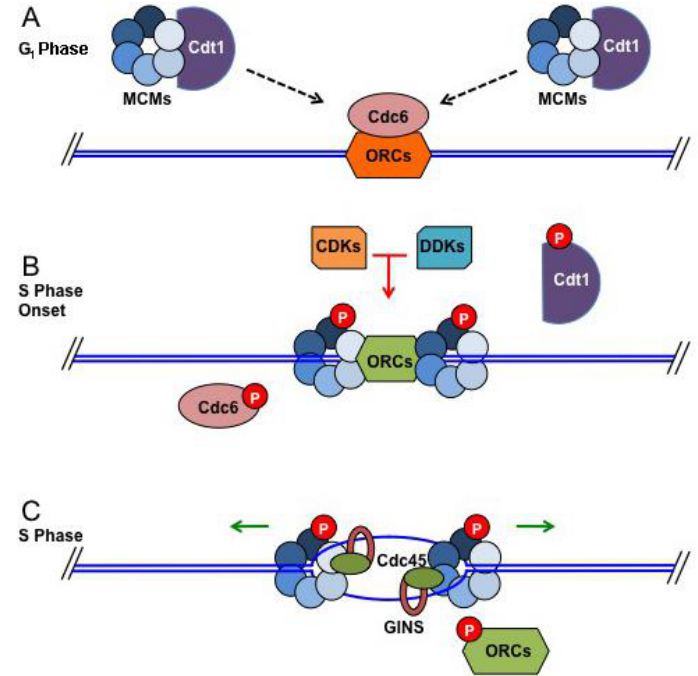
Figure 3. Mcm2-7 loads onto DNA at replication origins during G1 and unwinds DNA ahead of replicative polymerases. ( A ) The combined activities of Cdc6 and Cdt1 bring MCM complexes to replication origins. ( B ) CDK/DDK-dependent phosphorylation of pre-RC components leads to replisome assembly and origin firing. Cdc6 and Cdt1 are no longer required and are removed from the nucleus or degraded ( C ) MCMs and associated proteins (GINS and Cdc45 are shown) unwind DNA to expose template DNA. At this point